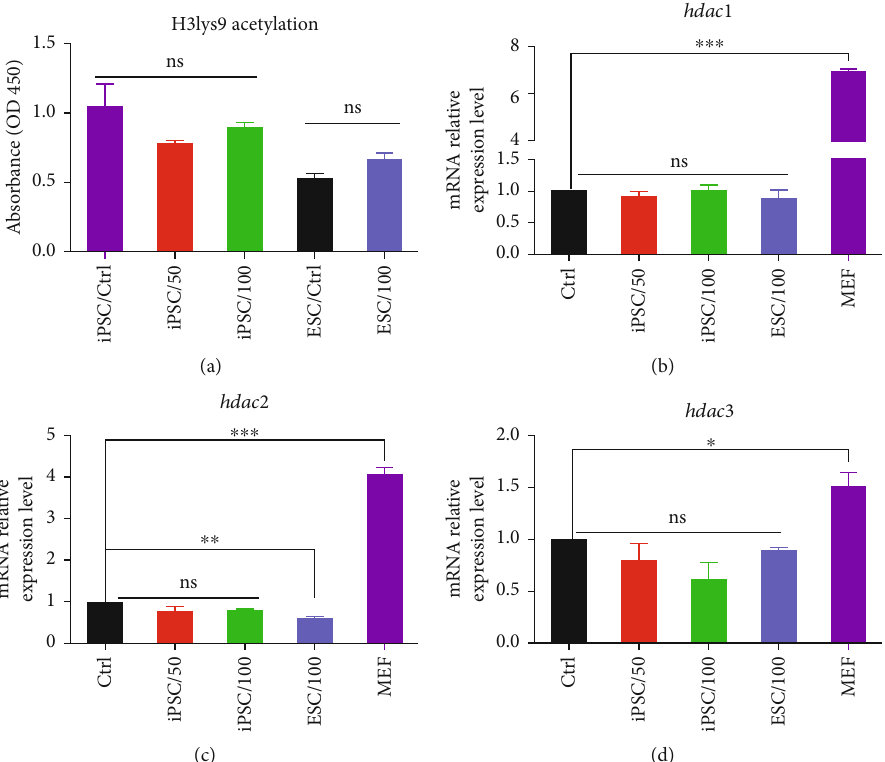
Figure 2: Histone acetylation assay and HDAC expression. (a) Histone acetylation was examined by H3Lys9 acetylation assay for the iPSCs treated with 50 and 100 nM of TSA during reprogramming and 100 nM TSA-treated NT-ESCs. All the groups were compared to the relevant control group. (b) – (d) hdac 1, 2, and 3 expressions were assessed by RT-PCR for all test groups and compared to control groups. ns: not signi fi cant; ∗ , ∗∗ , and ∗∗∗ indicate the statistical signi fi cance P < 0 : 05 , P < 0 : 01 , P < 0 : 001 , respectively, compared to the control